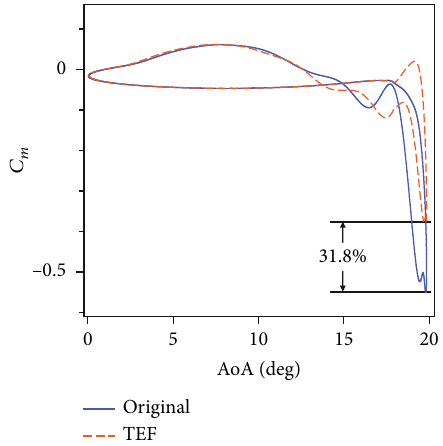
Figure 11: Comparison of pitching moment coe ffi cients between the original and TEF